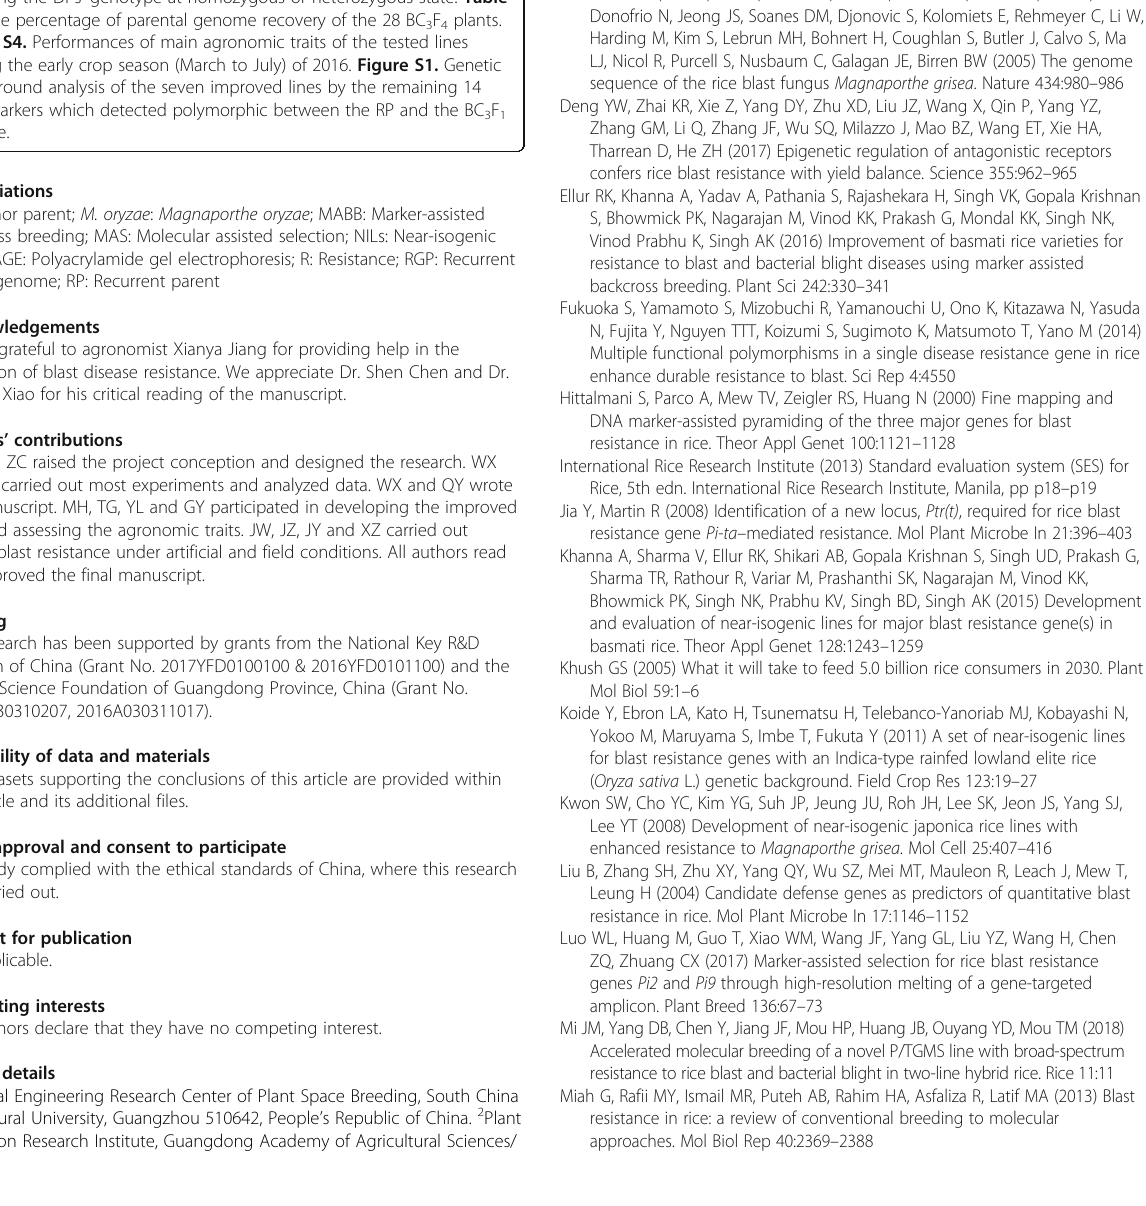
Additional file 1: Table S1. The 110 polymorphic markers between the RP and the DPs. Table S2. The information of the remaining 14 markers showing the DPs ’ genotype at homozygous or heterozygous state. Table S3. The percentage of parental genome recovery of the 28 BC 3 F 4 plants. Table S4. Performances of main agronomic traits of the tested lines during the early crop season (March to July) of 2016. Figure S1. Genetic background analysis of the seven improved lines by the remaining 14 SSR markers which detected polymorphic between the RP and the BC 3 F 1